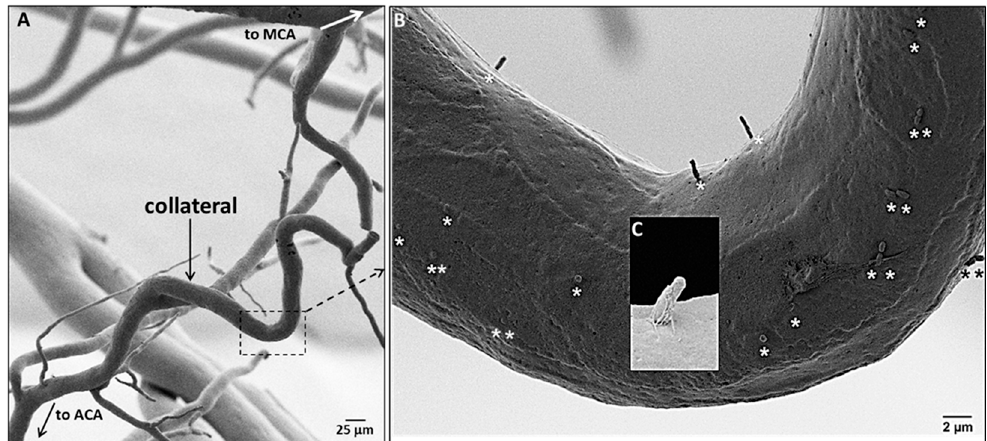
Figure 3. Collateral endothelial cells have primary cilia. ( A ) SEM of a corrosion cast of pial arterial vessels and a collateral, fixed at maximal dilation. ( B ) Stars identify casts of plasmalemmmal invaginations that contain the proximal end of the primary cilia (PrC) filled with Batson’s #17 after removal of the PrC by shearing during infusion of the casting agent; each EC has 0–3 PrC. ( C ) Higher magnification SEM of a ~2 µm long PrC invagination.